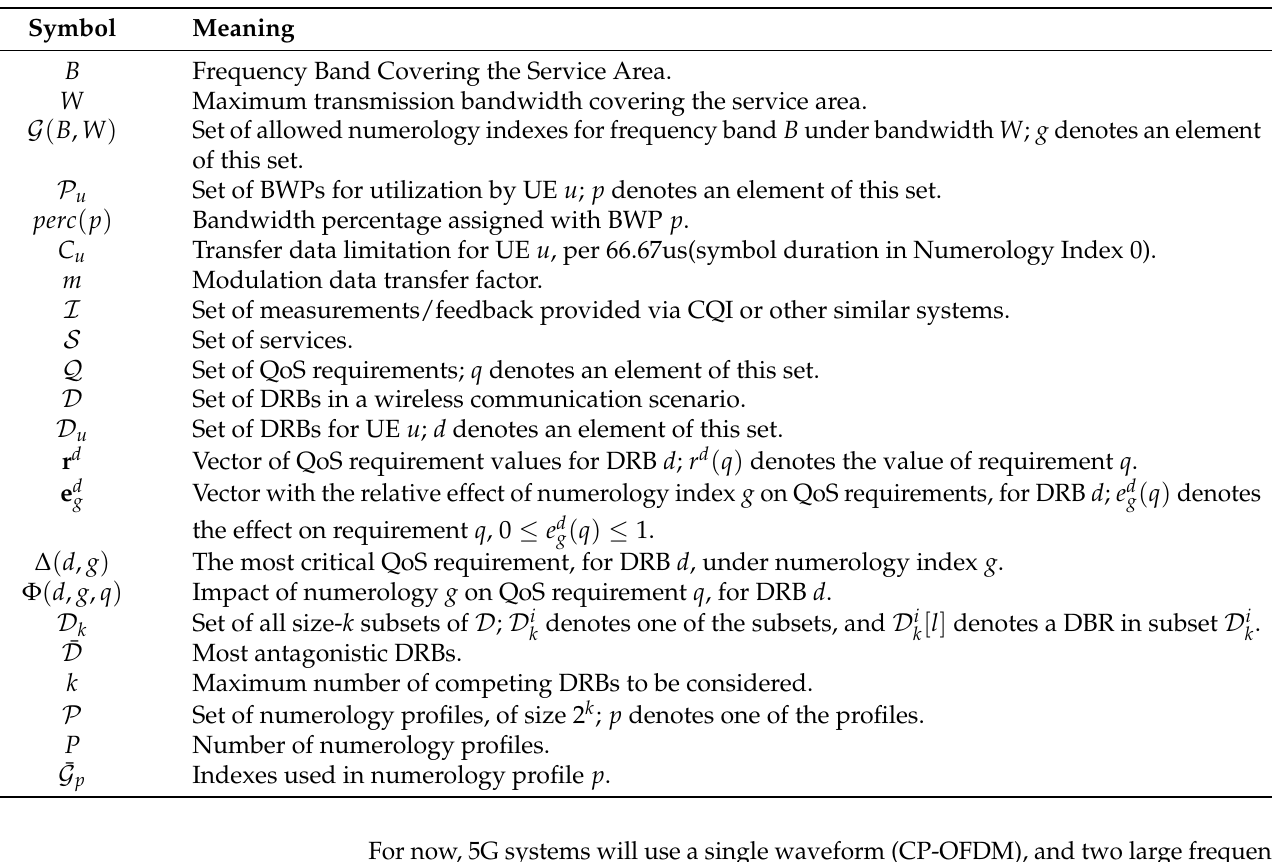
Table 3. Notation. CQI, channel quality information; DRB, data radio